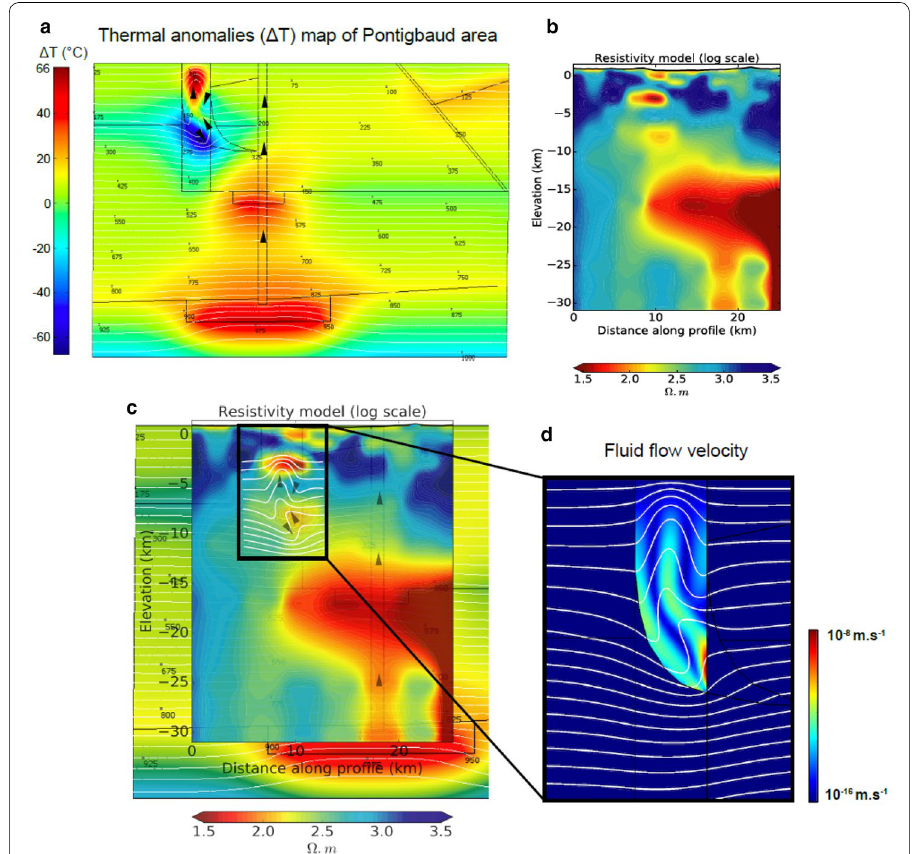
Fig. 14 a Thermal anomalies maps of Pontgibaud area. The black arrows represent the direction of fluid flow. b Resistivity model previously described (Fig. 3). c Comparison of the numerical simulation result